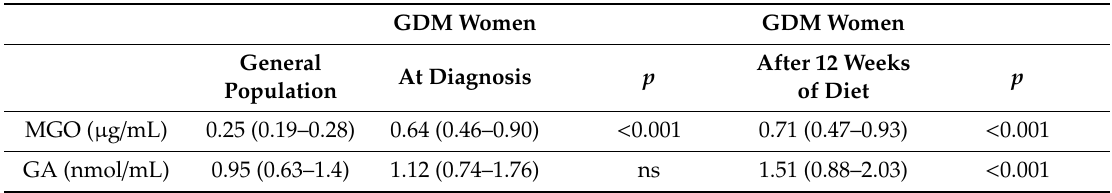
Table 3. Comparison between MGO and GA in general population and women with GDM at the diagnosis and after 12 weeks of